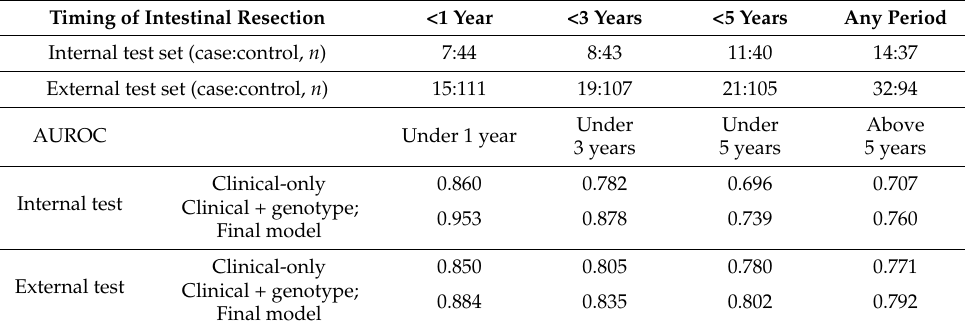
Table 3. Comparison of model performance with various criteria of early intestinal resection.